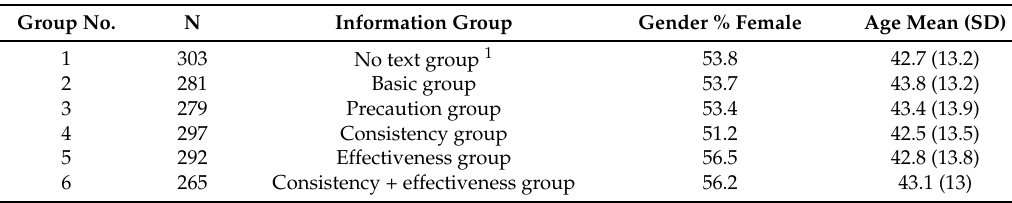
Table 1. Different types of messages about radiofrequency electromagnetic fields (RF-EMFs) from mobile phones in the different study